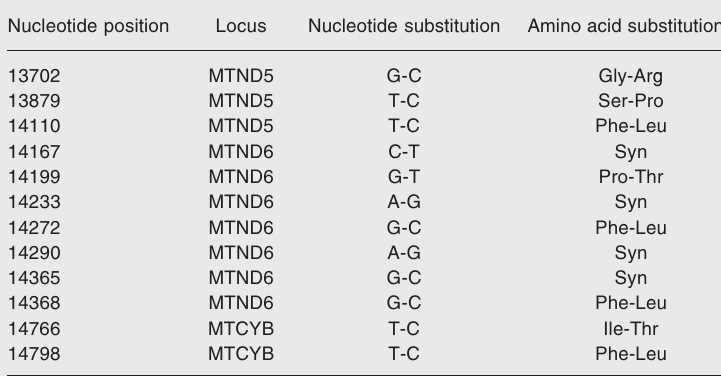
Table 1. Nucleotide substitutions observed in an Iranian